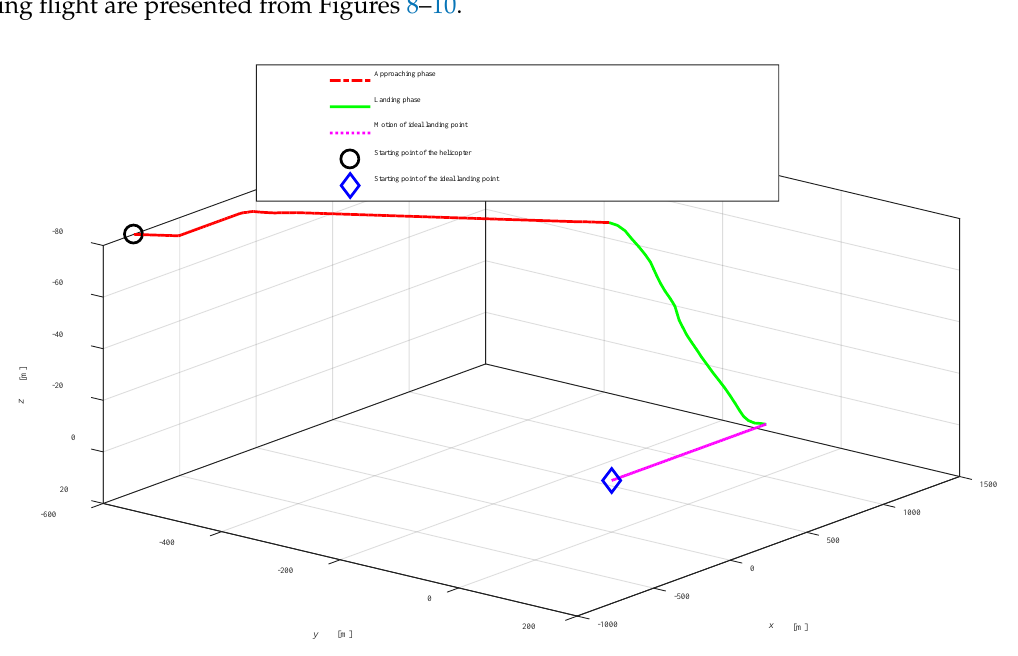
Table 3. The terminal state of the helicopter and the ideal state.